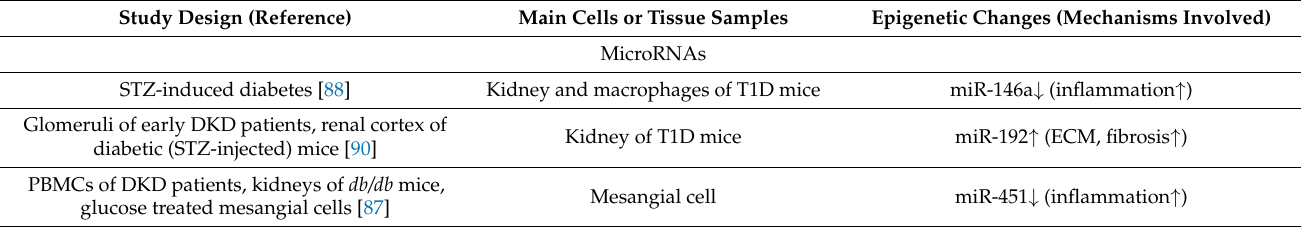
Table 3. Noncoding RNAs in diabetic kidney